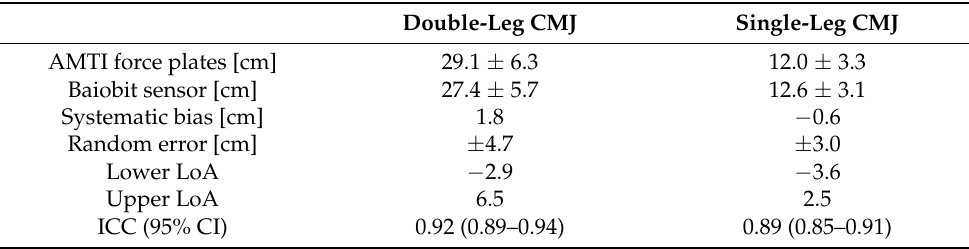
Table 3. Validity of the AMTI force plates and Baiobit sensor for jump height.